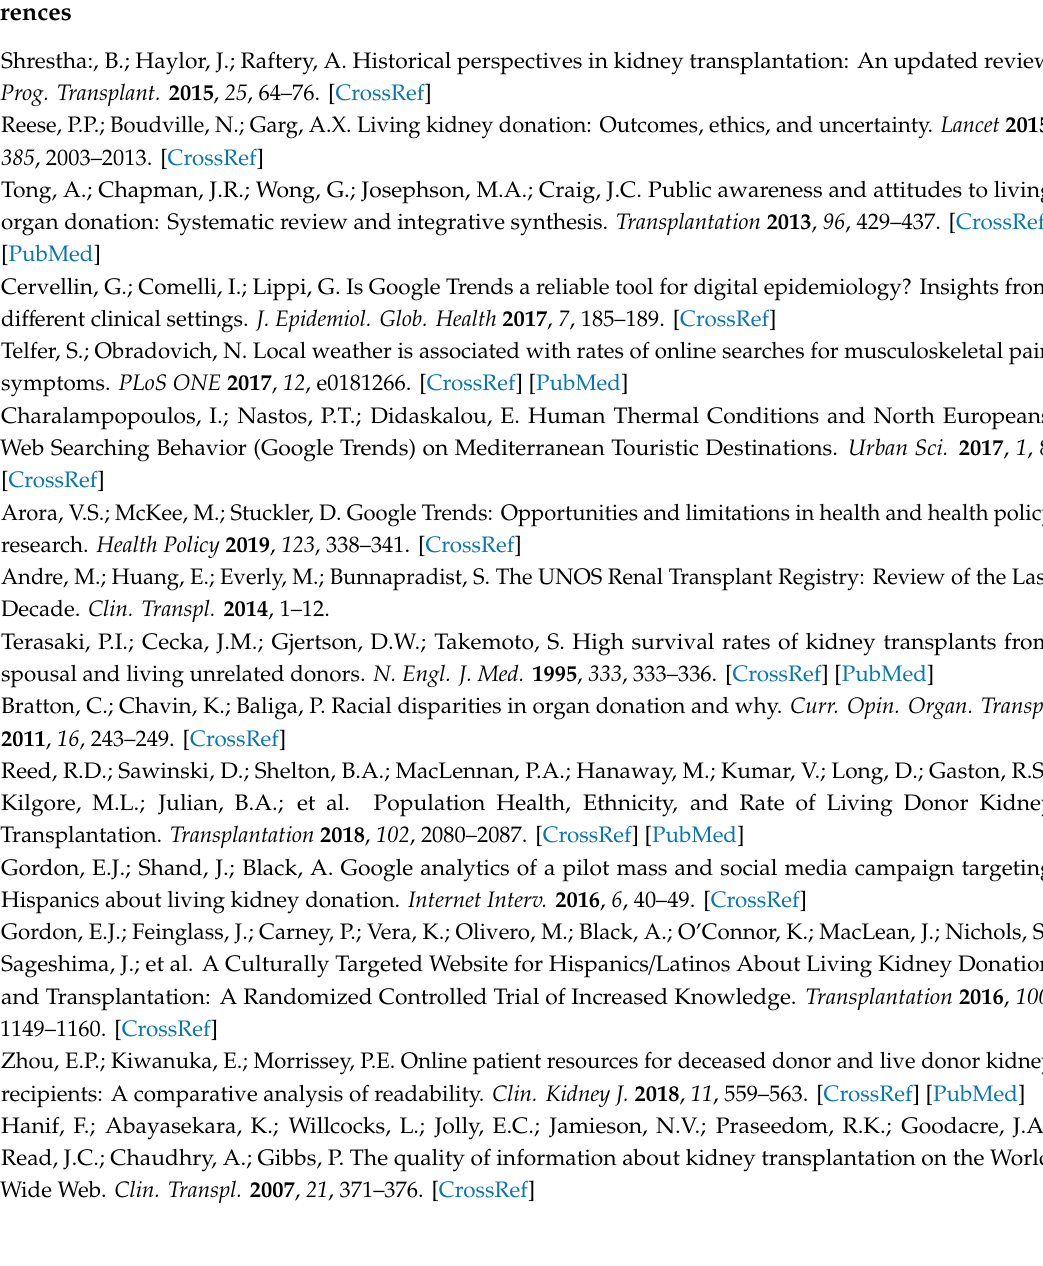
Table S1: Search terms for the respective countries and languages are given, Table S2: The numbers of deceased donor and living donor kidney transplantations over time are